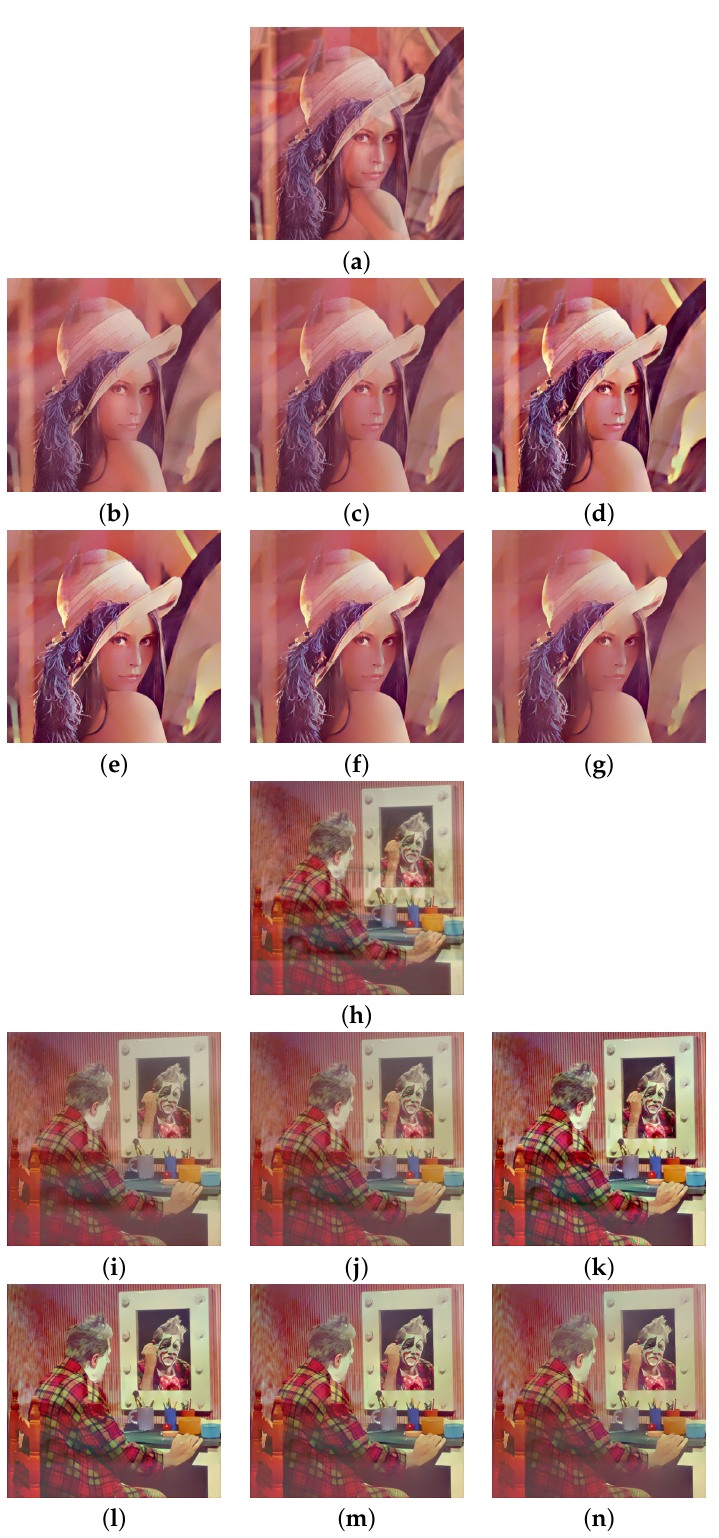
Figure 3. Reflection suppression results for synthetic glass images with w = 0.7. ( a , h ) Input images. ( b , i ) The results of algorithm [2]. ( c , j ) The results of algorithm [3]. ( d , k ), ( e , l ), ( f , m ), and ( g , n ) are results of the proposed algorithm with N = 1,2,3,4,